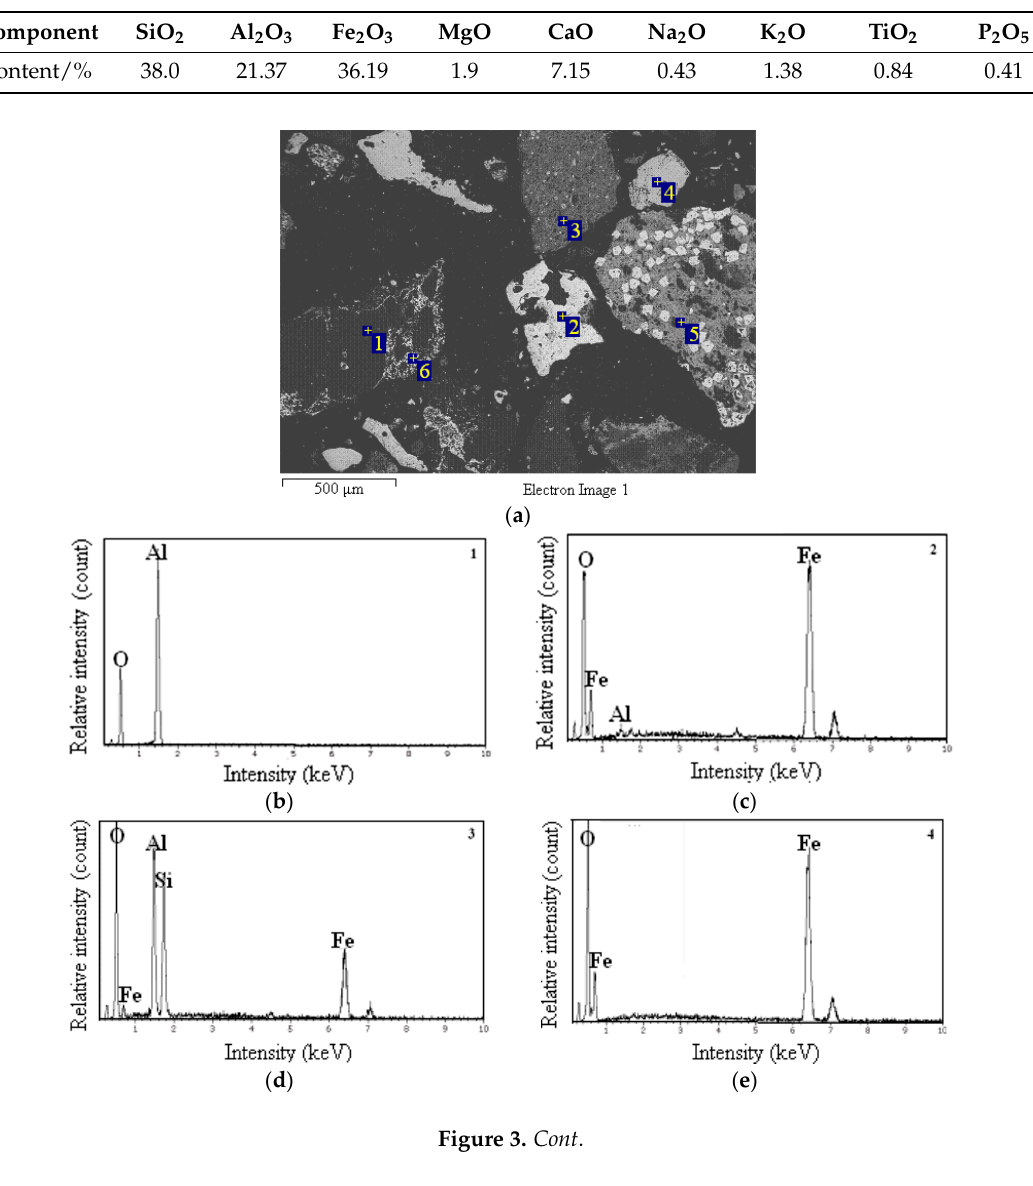
Table 3. Inorganic composition of coal ash. Table 3 . Inorganic composition of coal ash.